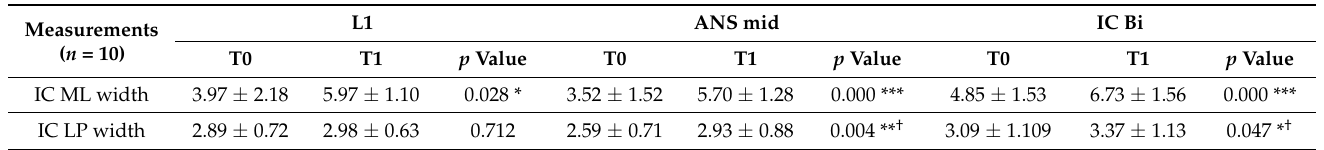
Table 3. Changes in IC dimensions after MARPE treatment in samples where the maxillary central incisors and the IC were vertically separated (mean ± standard deviation).